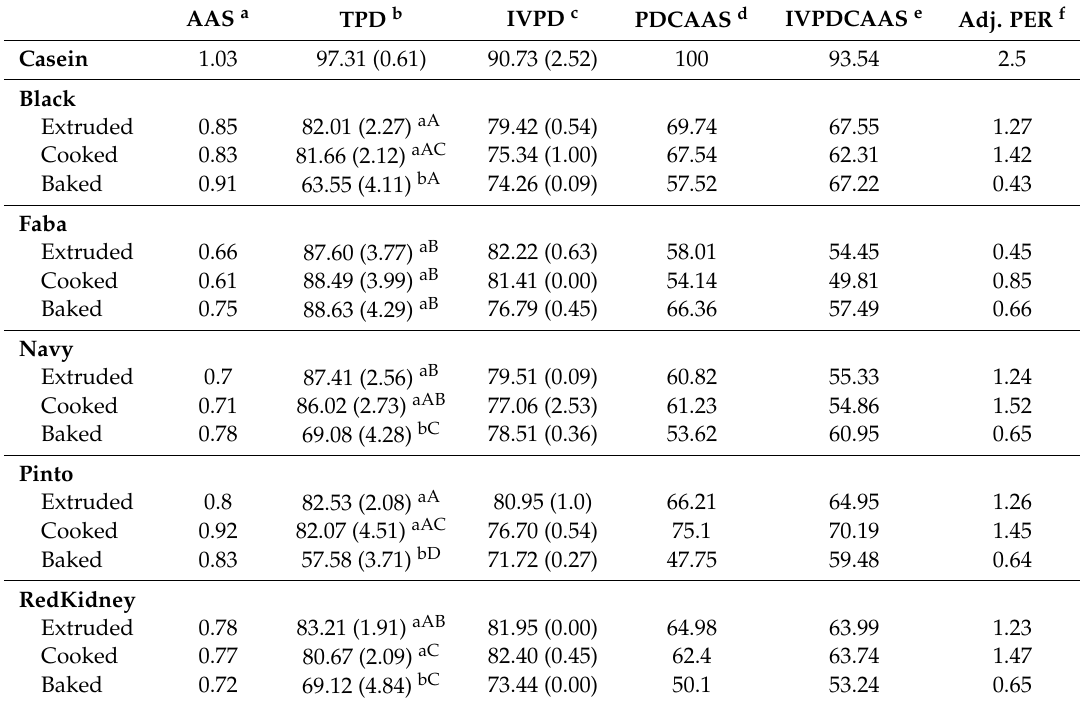
Table 4. Adjusted protein efficiency ratio, protein digestibility-corrected amino acid scores and in vitro protein digestibility-corrected amino acid Scores of extruded, cooked and baked